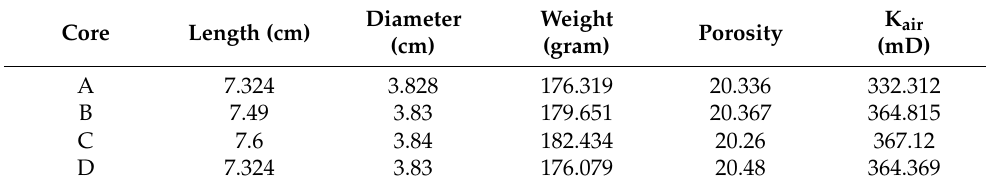
Table 2. Petrophysical properties of cores used for coreflooding